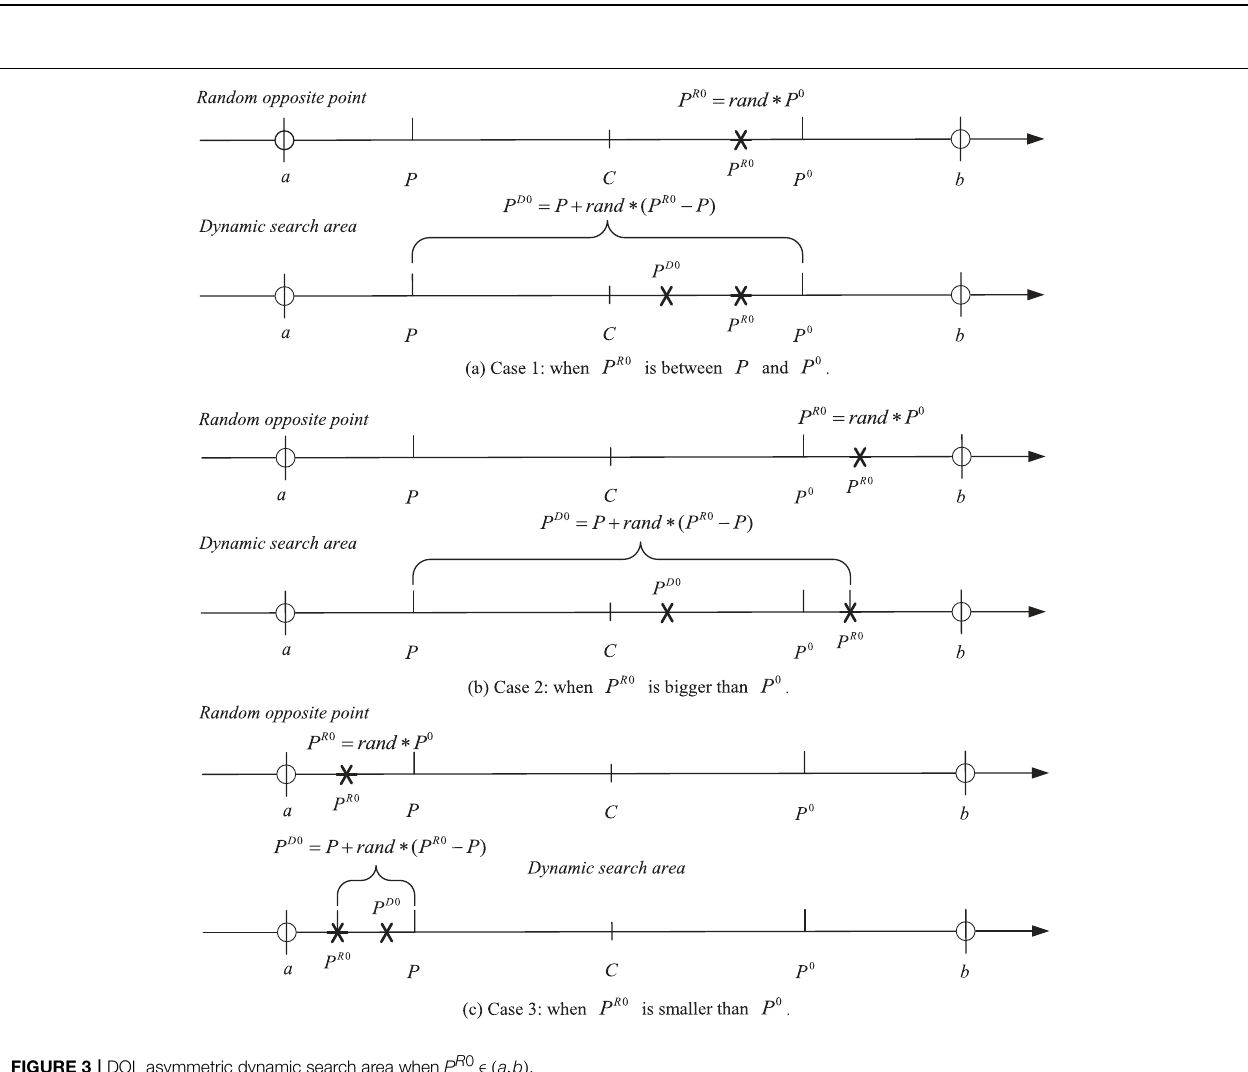
FIGURE 2 | Symmetric area between the current point and the opposite point.